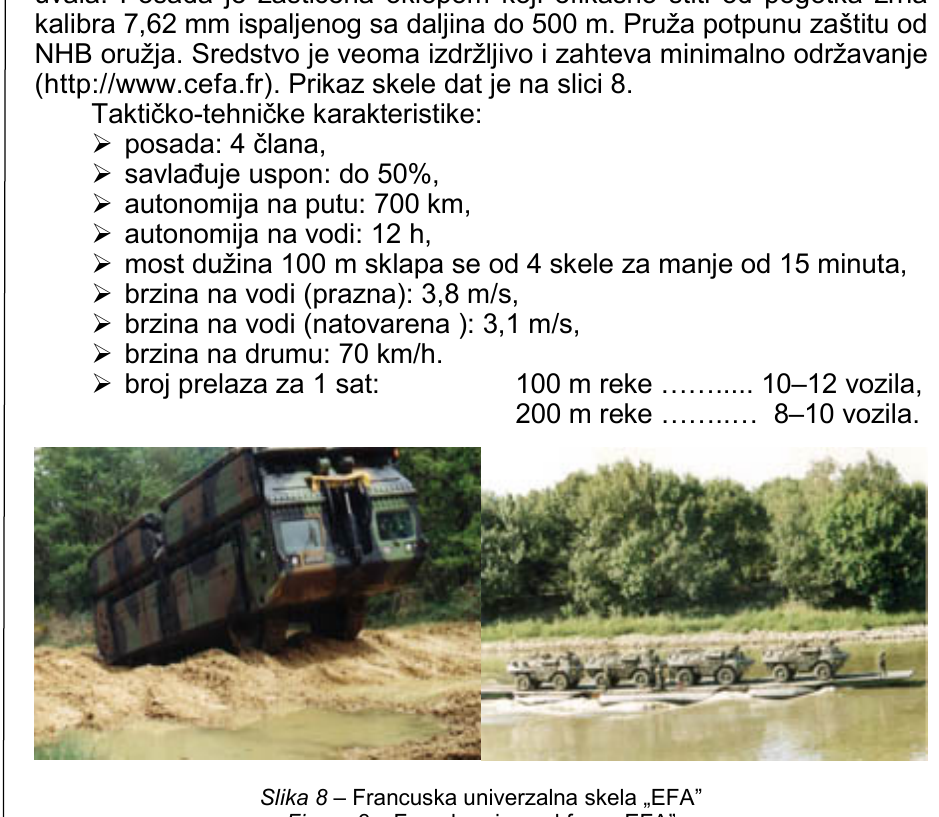
Figure 8 – French universal ferry